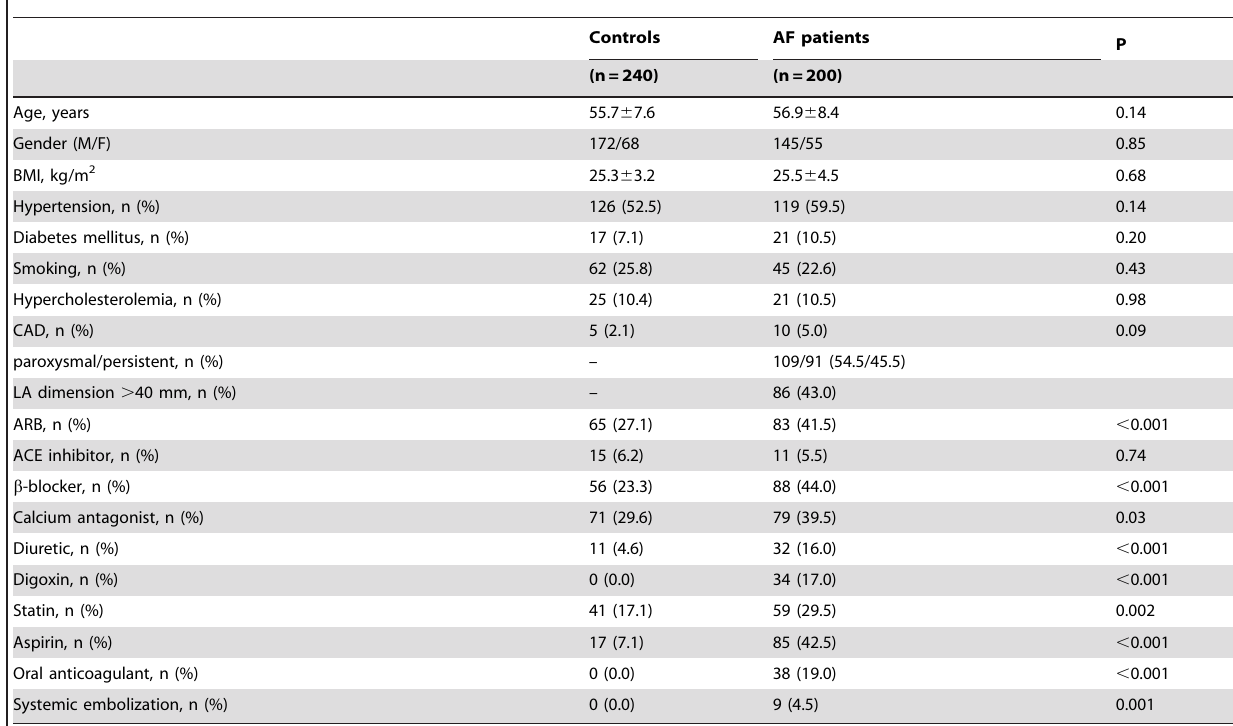
Table 1. Demographic and Clinical Characteristics of the Study Population.